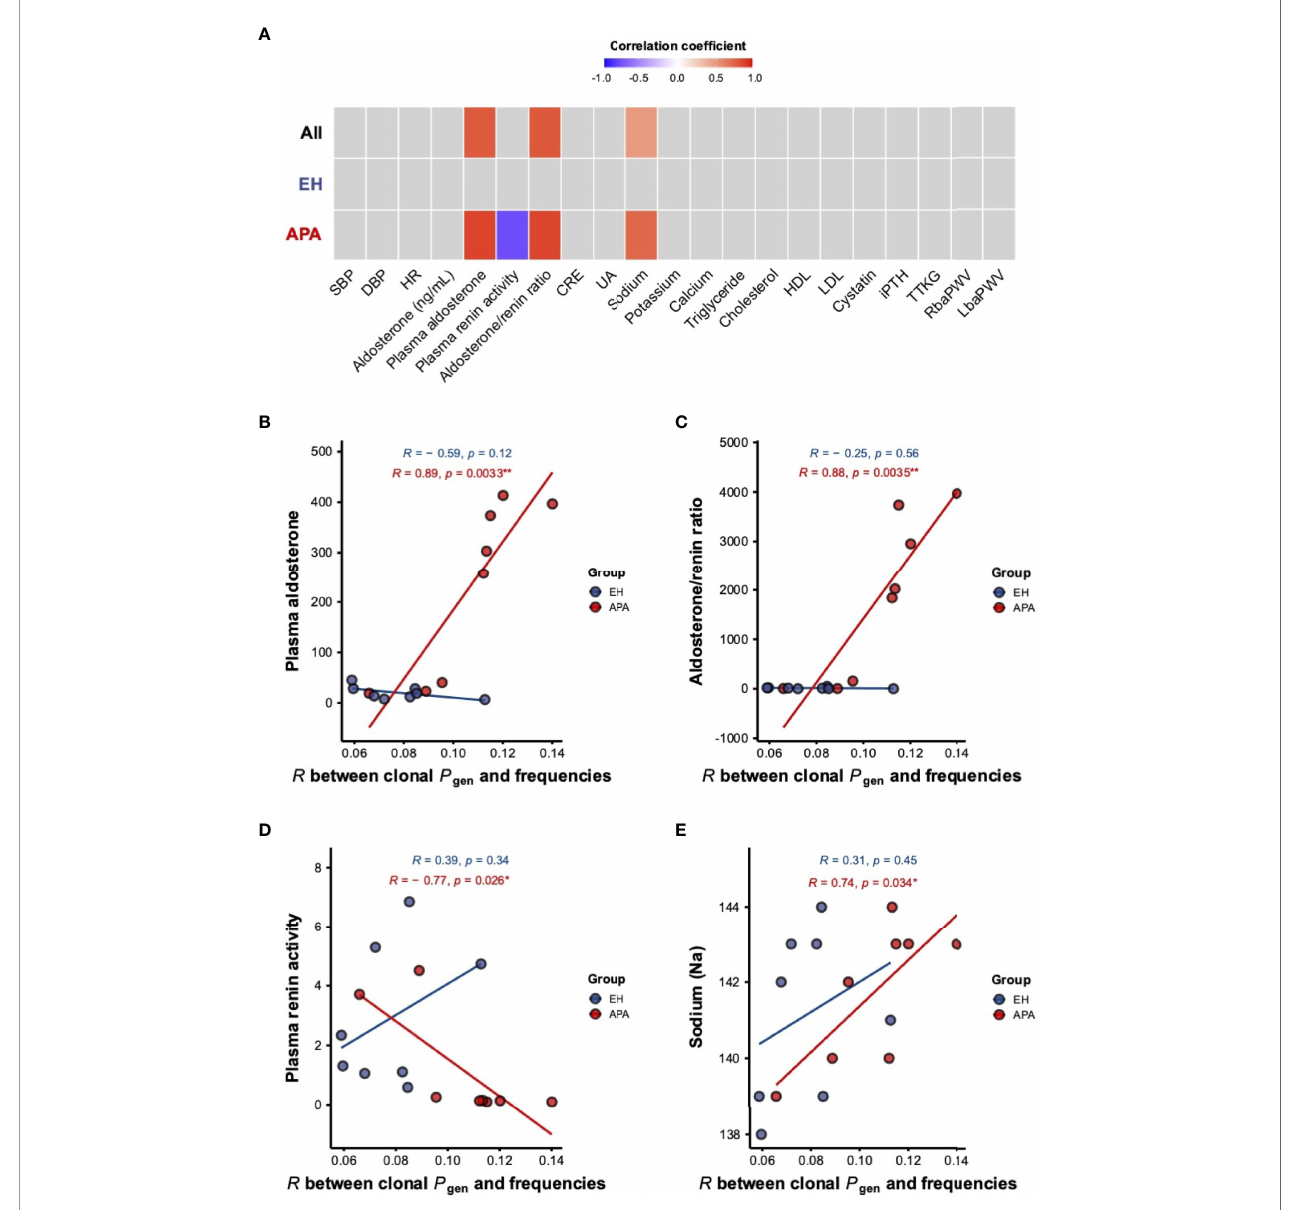
FIGURE 4 | The association of clinical measurements with the strength of correlation between frequencies and P gen of TCR b clonotypes in APA and EH patients. (A) Pearson correlation coef fi cients for the associations of different clinical features with the strength of the correlation between clonal frequencies and P gen in all patients and the APA and EH groups were shown in a heat map. Associations with p -values <0.05 were considered to be statistically signi fi cant and colored either in red (positive) or blue (negative). (B – E) Linear correlations of PAC (B) , ARR (C) , PRA (D) , and blood sodium level (E) with the correlation coef fi cient between frequencies and P gen of TCR b clonotypes were illustrated. Pearson ’ s r ( R ) and p -value ( p ) of the association were computed for APA (red) and EH (blue) patients. p -values <0.05 or <0.01 were considered to be statistically signi fi cant and marked with “ * ” or “ ** ” , respectively. SBP, systolic blood pressure; DBP, diastolic blood pressure; HR, heart rate; CRE, creatinine; UA, uric acid; HDL, high-density lipoprotein; LDL, low-density lipoprotein; iPTH, intact parathyroid hormone; TTKG, transtubular potassium gradient; RbaPWV, right brachial-ankle pulse wave velocity; LbaPWV, left brachial-ankle pulse wave